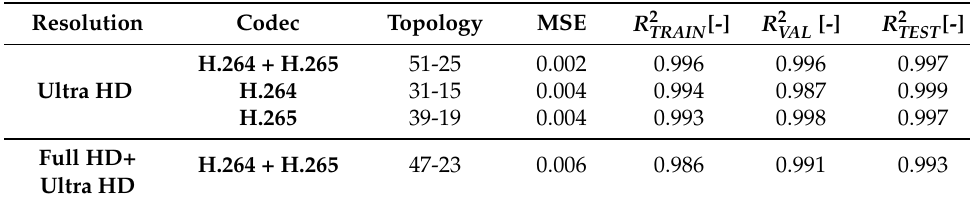
Table 5. Simulation of the MOS prediction for the best